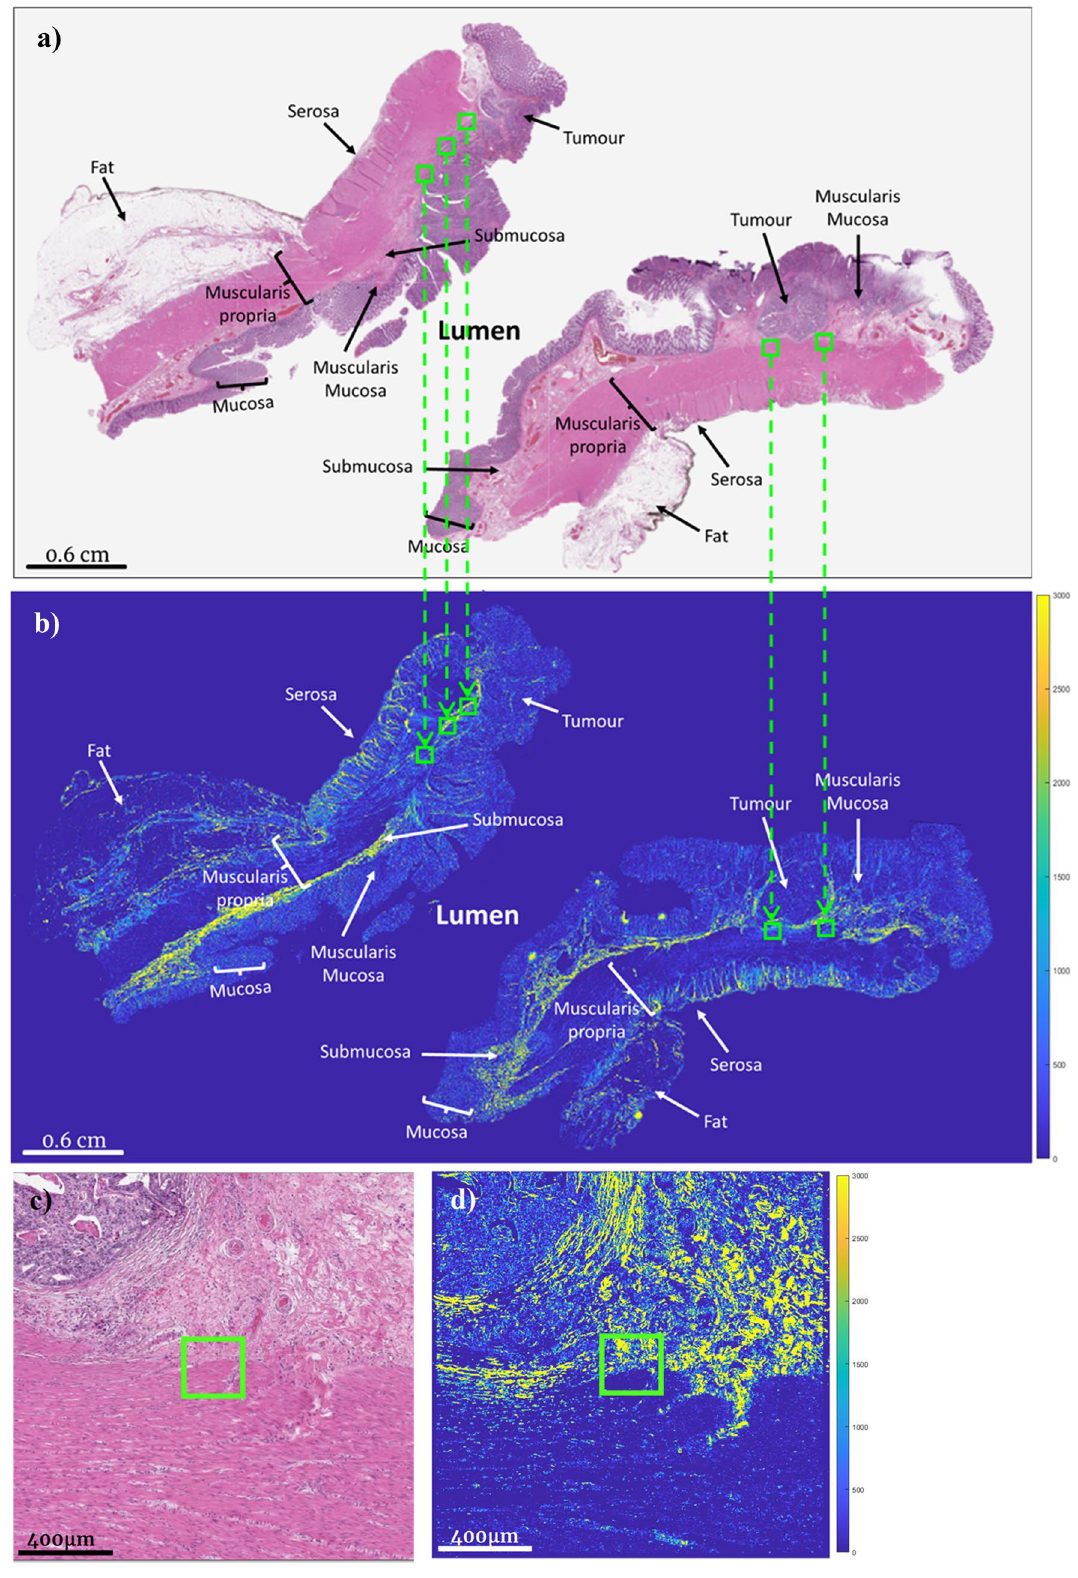
Figure 1. Whole-slide and ROI-based histologic and polarimetric imaging of a stage III CRC sample for qualitative ROI-based analysis. ( a ) H&E-stained slide and ( b ) corresponding polarimetric intensity image of an adjacent unstained slide (see Polarimetric image quantification & analysis section). ( c ) H&E and ( d ) polarimetric intensity zoomed-in images of the region around the right-most ROI in ( a ) and ( b ). The brighter areas visualize birefringent tissues that contain more collagenous stroma. The green squares represent the ROIs identified by the pathologist on the H&E images at the leading edges of the tumour, and the arrow show their transfer onto the polarimetric images. Images were obtained at 20 × magnification and were tiled and stitched for ( a ) and ( b ), and at 80 × for ( c ) and ( d